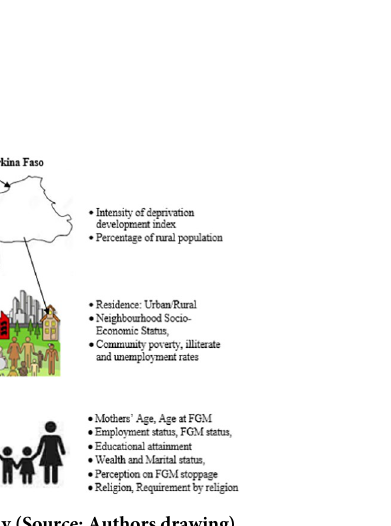
Fig 1. The hierarchical nature of the data used in this study (Source: Authors drawing).